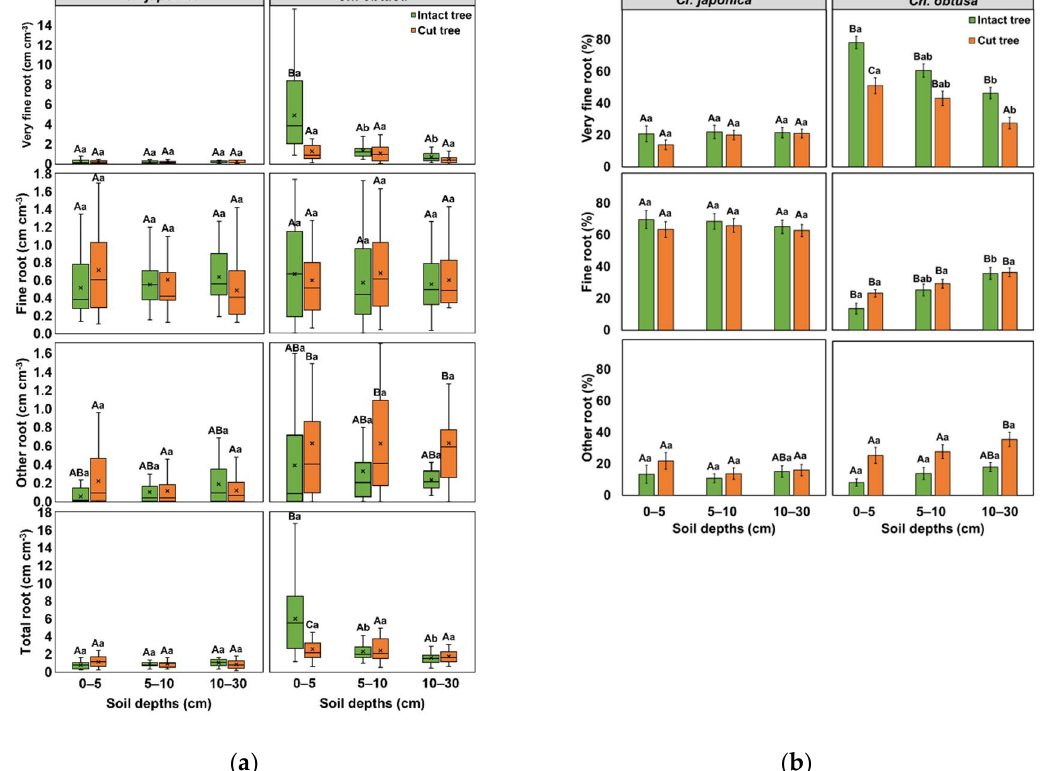
Figure 3. Root length density (cm cm − 3 ) for di ff erent soil depths of Cryptomeria japonica and Chamaecyparis obtusa intact tree and cut tree plots. ( a ) Root (very fine, fine, other, and total) length density; ( b ) Root (very fine, fine, and other) length density percentage to total root length density. Capital and small letters denote significant differences between plots and different soil depths, respectively (n = 20).